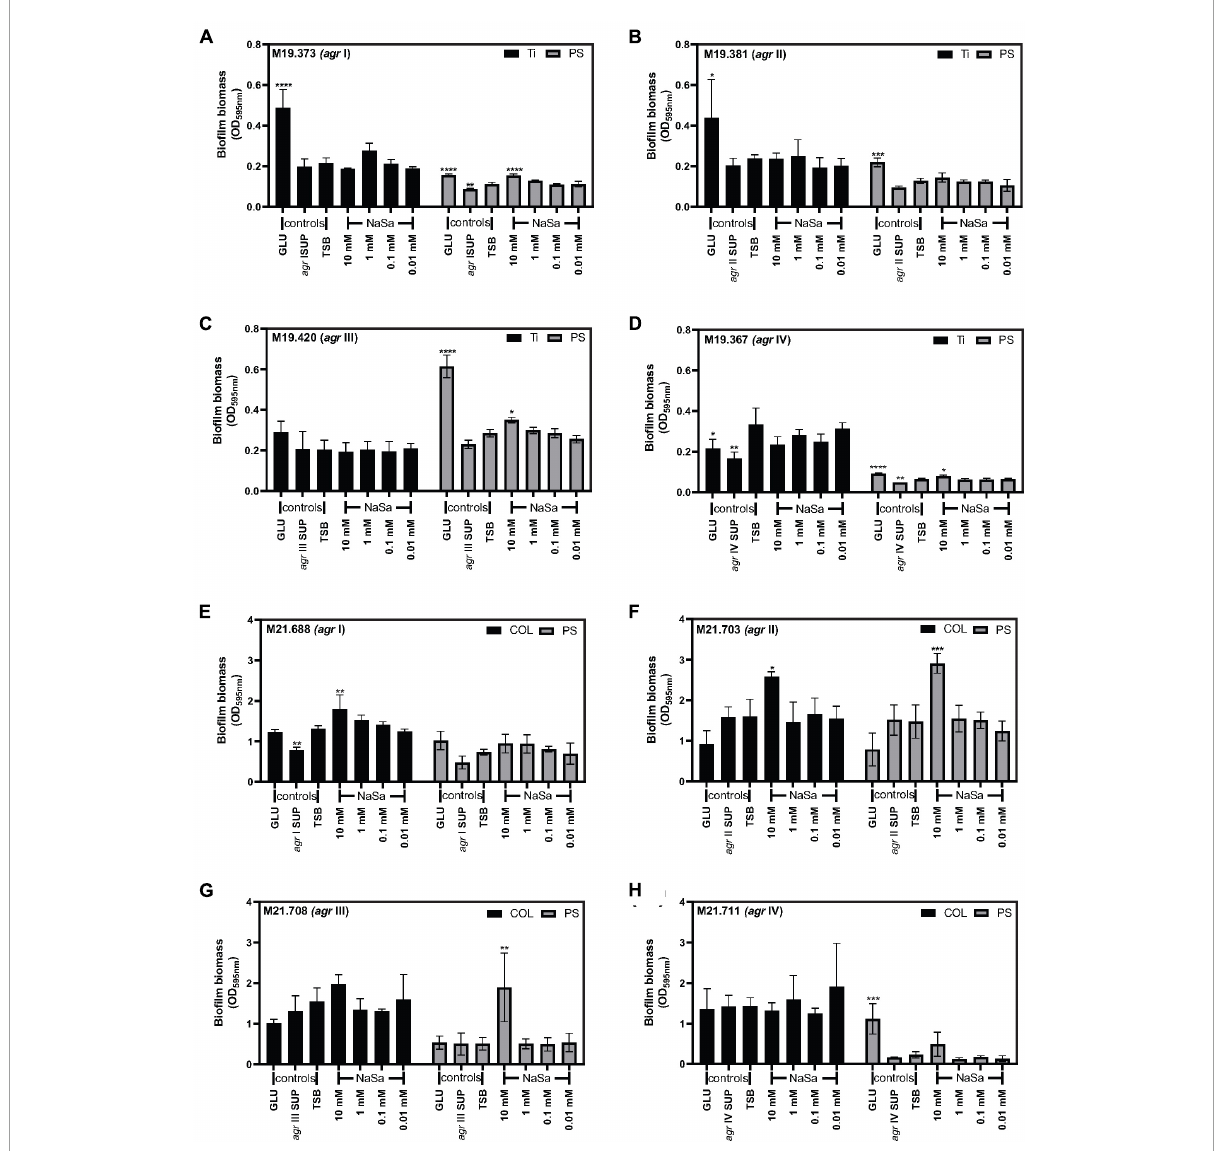
FIGURE6 Biofilm formation influenced by NaSa depends on the strain agr type and material substrate. Effect of NaSa on biofilm formation after 24 h on polystyrene (PS) and titanium (Ti) by isolates from periprosthetic joint infections (A–D) and on polystyrene and collagen-coated polystyrene (COL) by isolates from wound infections (E–H) . Biofilm biomass was evaluated using crystal violet. Data represent the means from three independent experiments ± SD . * P ≤ 0.05, ** P ≤ 0.01, *** P ≤ 0.001, **** P ≤ 0.0001, statistically significant to TSB (Tryptic Soy Broth) as media using one-way ANOVA Dunnett’s test. GLU, glucose; SUP, supernatant from the respective S. aureus clinical